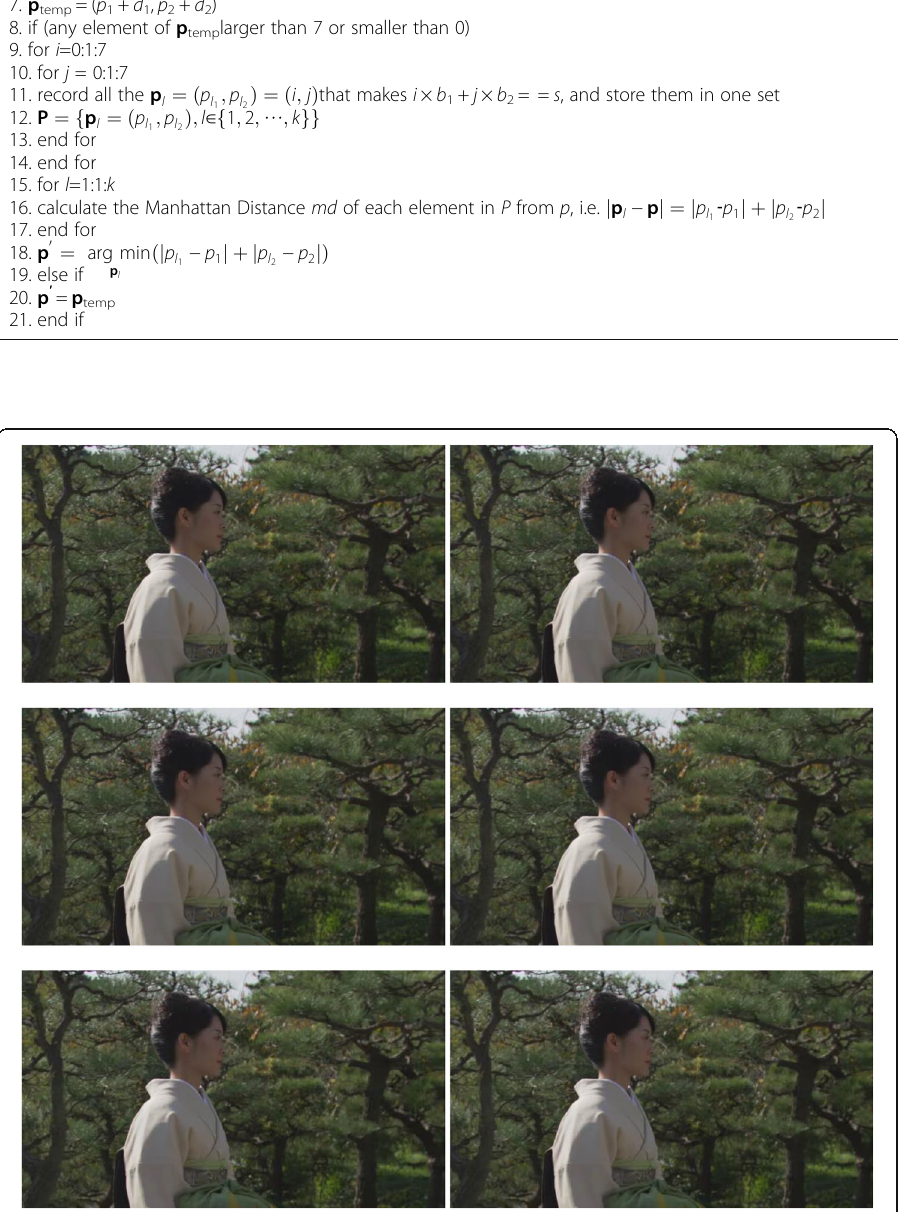
Fig. 6 Subjective visual quality evaluation at different QPs for Kimino 1920 × 1080. The original pictures are laid on the first column, and pictures with hidden information are placed in the second column. The QP adopted in the first line, second line, and third line are 26, 32, and 38, respectively